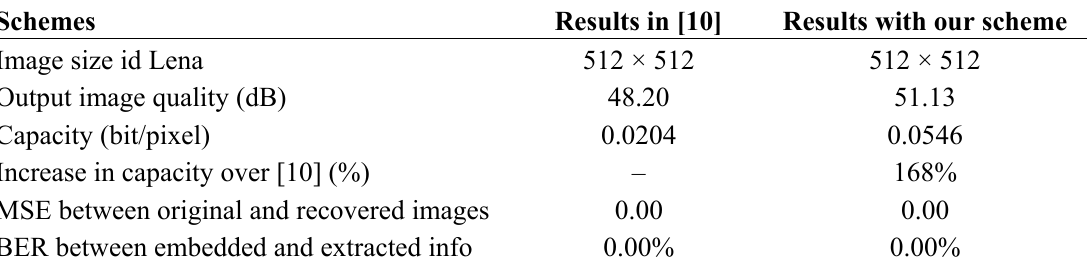
Table 3. Comparisons with [10] for test image